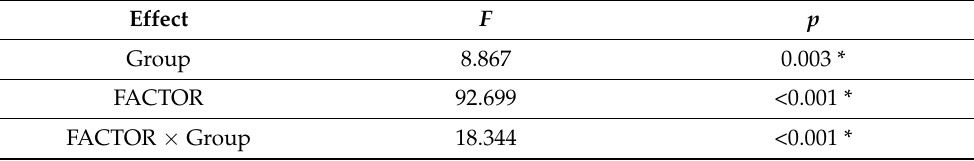
Table 2. Analysis of variance for Resilience Measurement Scale